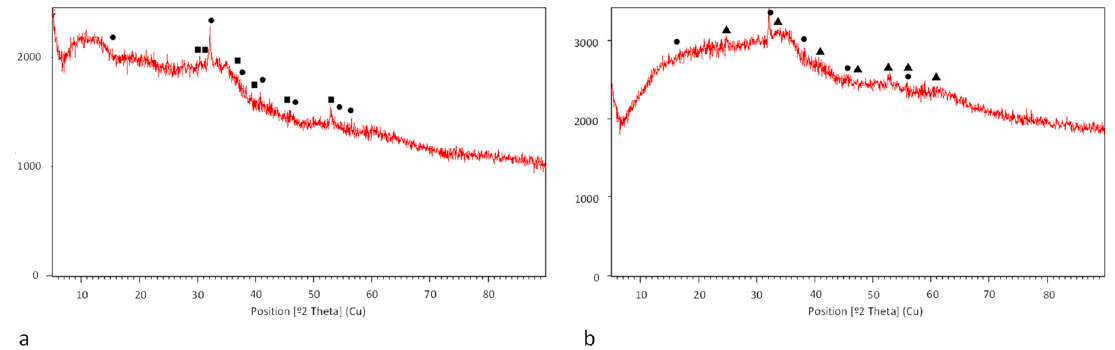
Figure 4. XRD patterns of iron precipitates produced by the natural consortium after the adsorption experiments with ( a ) As(III) and ( b ) As(V) ( ● , As 4 O 6 ; ■ , As 2 O 3 ; ▲ , As).